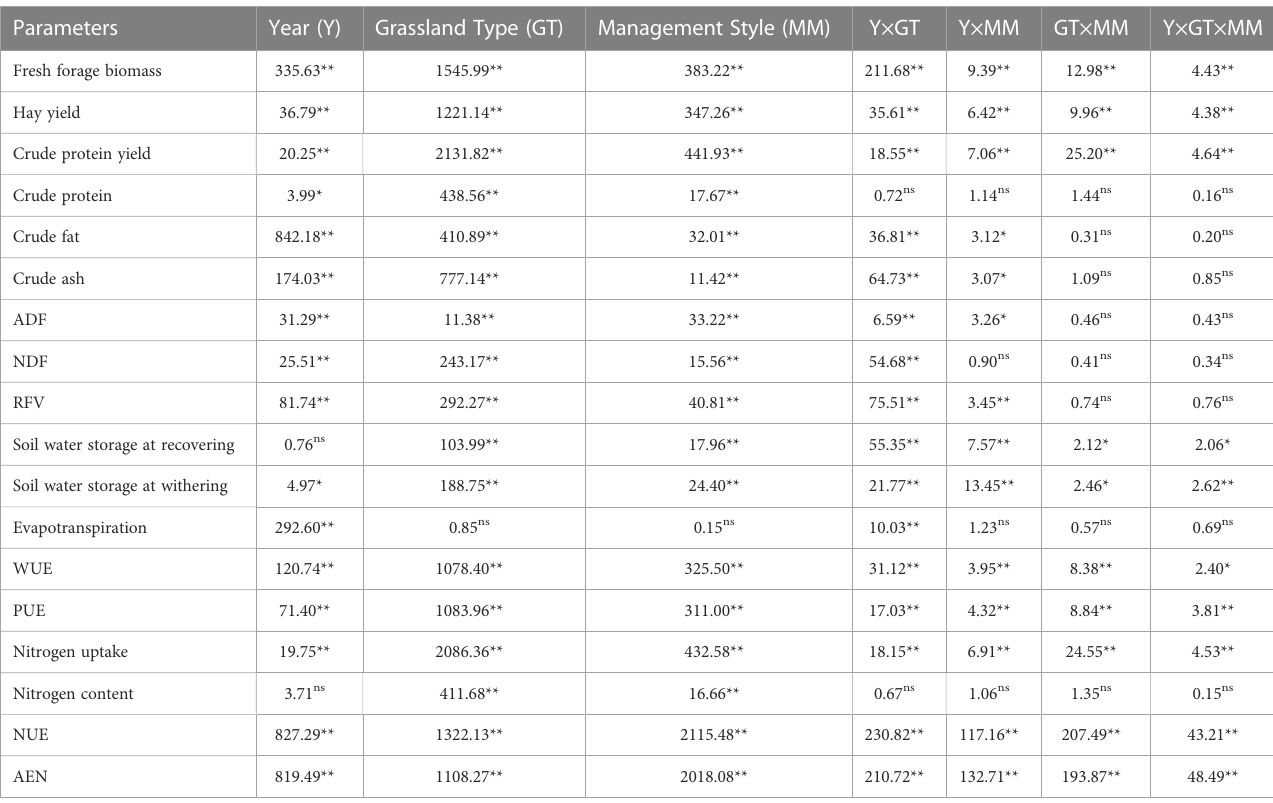
TABLE 1 ANOVA results for the effect of the year, grassland type, management style, and their interactions on fresh forage biomass, hay yield, crude protein yield, the content of crude protein, crude fat, crude ash, acid detergent fi ber (ADF), neutral detergent fi ber (NDF), and relative feed value (RFV); soil water storage, evapotranspiration, water use ef fi ciency (WUE), precipitation use ef fi ciency (PUE); nitrogen uptake, nitrogen content, nitrogen use ef fi ciency (NUE) and agronomic ef fi ciency of nitrogen (AEN) in 2019-2020.